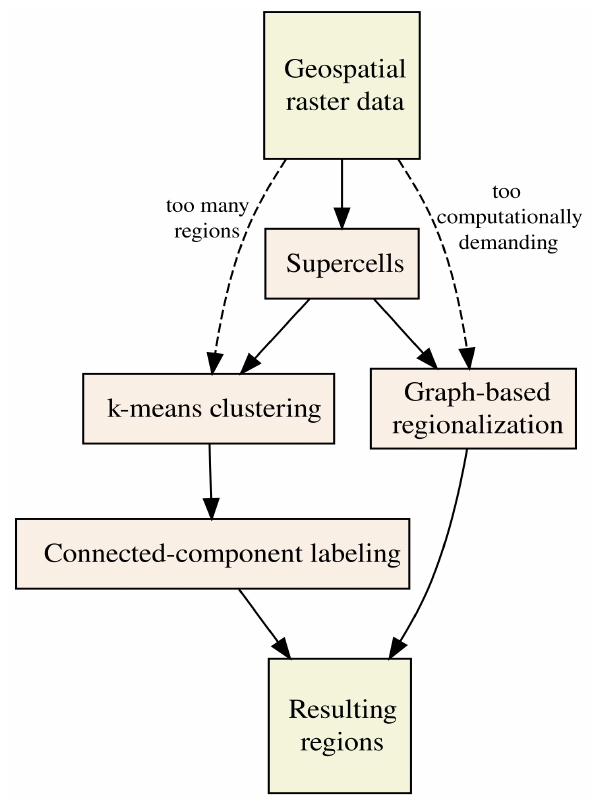
Figure 2. Possible approaches for regionalization of geospatial raster